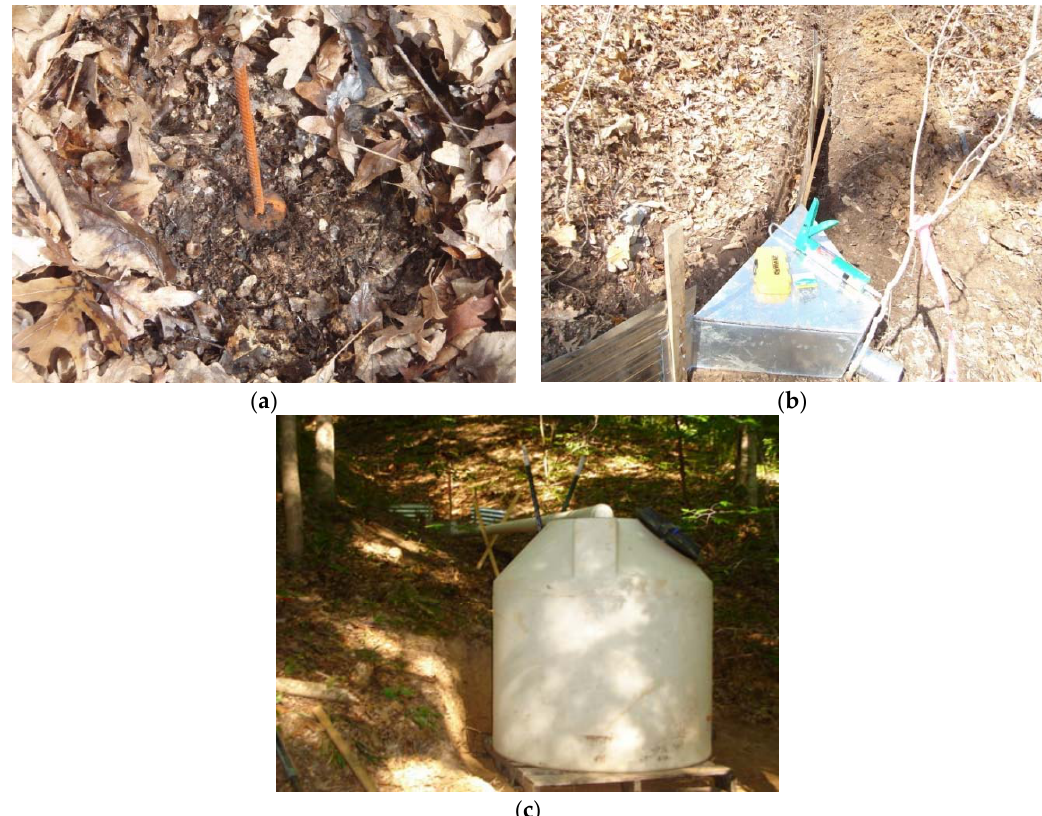
Figure 2. Erosion pin installed flush with the soil surface ( a ). Installation of galvanized metal flume ( b ) and complete set up of flume and tank design ( c